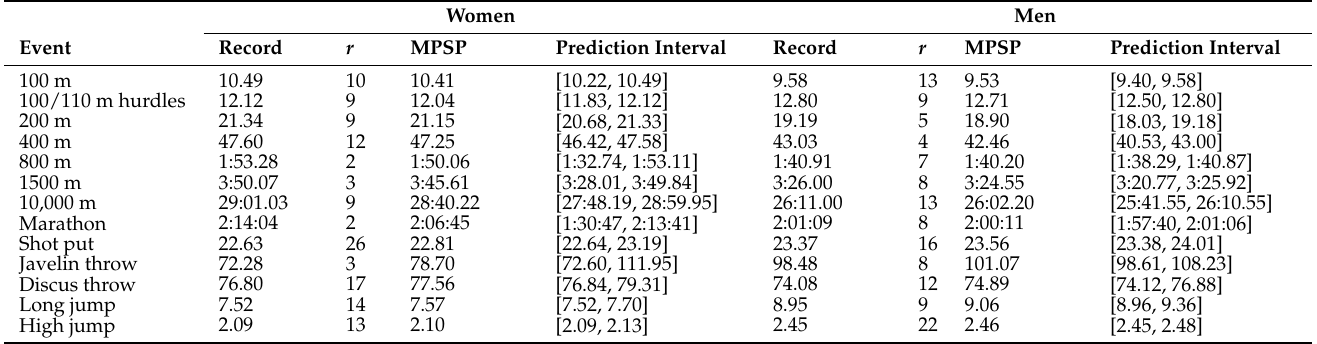
Table 4. World records (until 2022), maximum product of spacings predictor and 90% prediction interval I 2 / I (cid:48) for the next record based on the previous records for various athletic 2